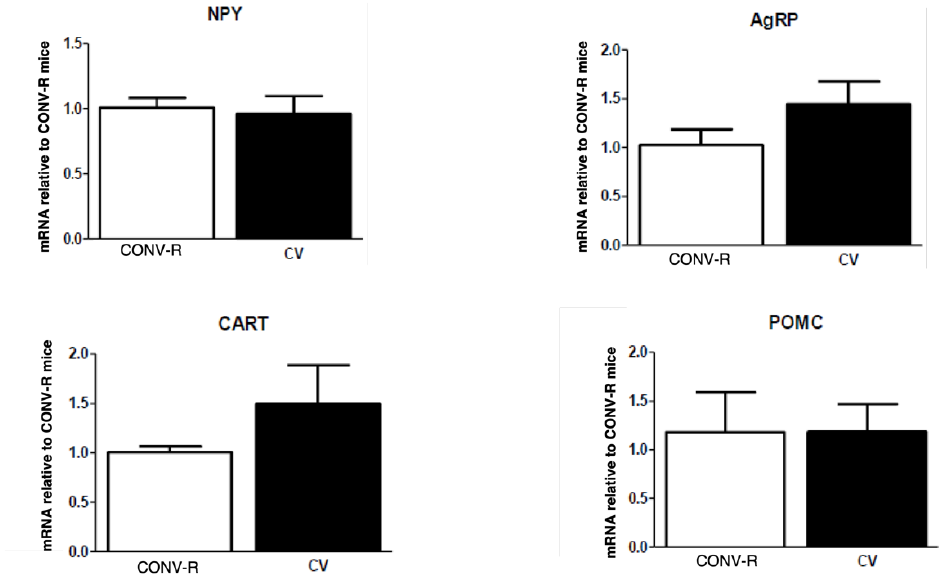
Figure 5. qPCR of hindbrain central peptides in 10 days conventionalized (CV) vs. CONV-R. mRNA expression levels of CV mice are relative to the mean level of CONV-R counterparts. Data are expressed as means ± SEM.